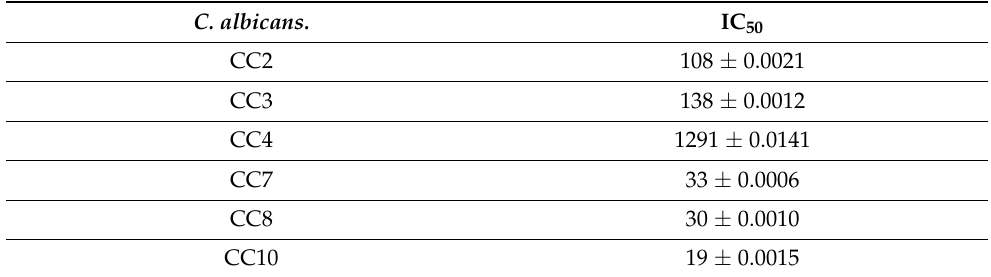
Table 3. Effect of Mexican propolis on the inhibition of germ tube growth of C. albicans